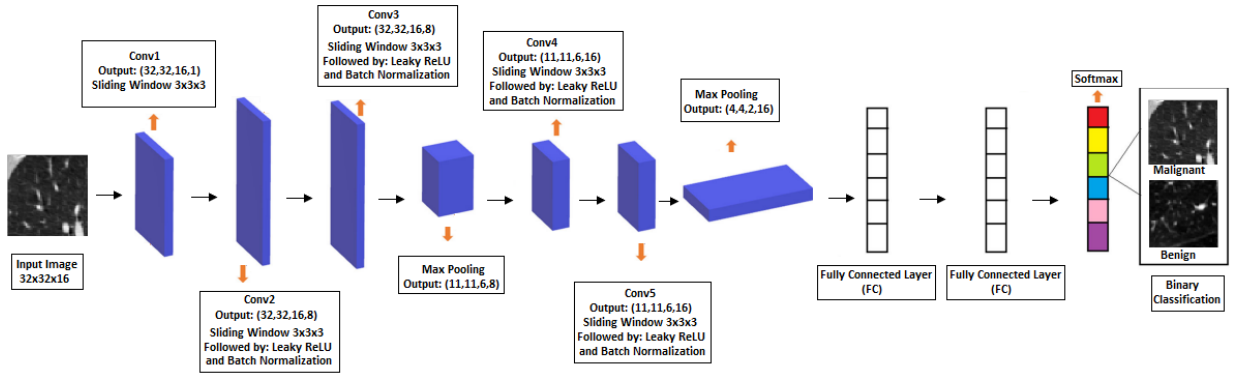
Figure 4. Three-dimensional CNN